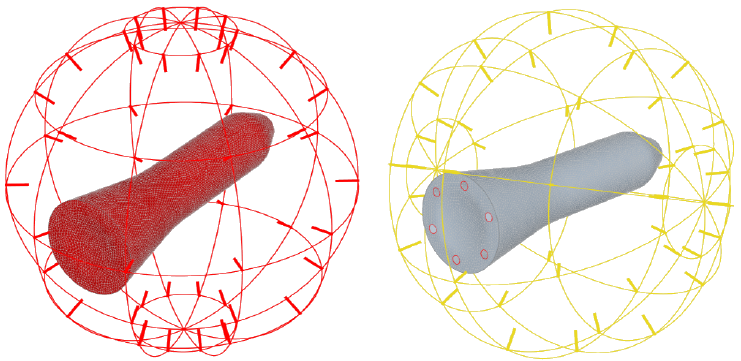
Figure 7. HB–2 Boundary Element Models in Wave6: left, model of the external air volume; and right, model of external and internal air